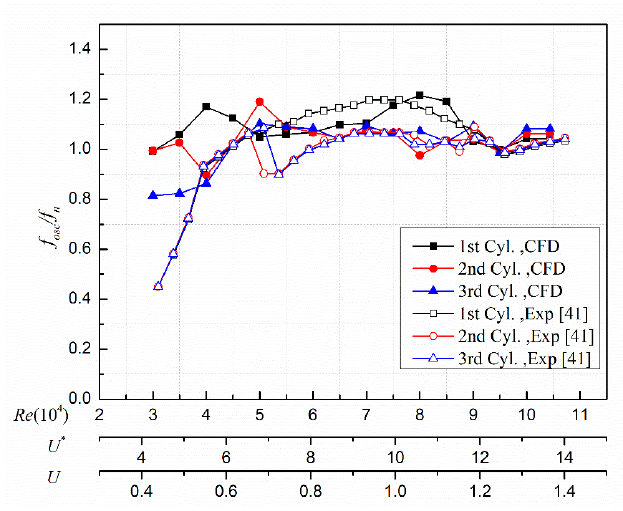
Figure 5. Frequency responses of three cylinders in FIV.